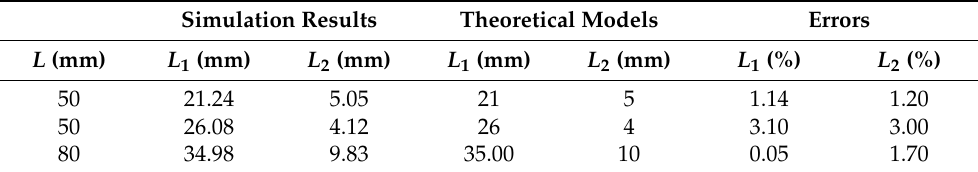
Table 1. The location results of different cases.